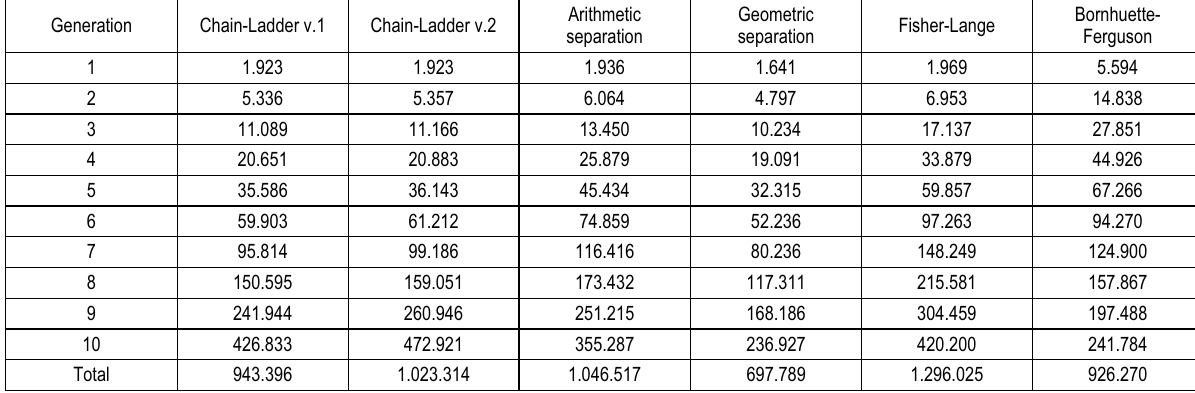
Table 15. Mean square error Pentikainen-Rantala method